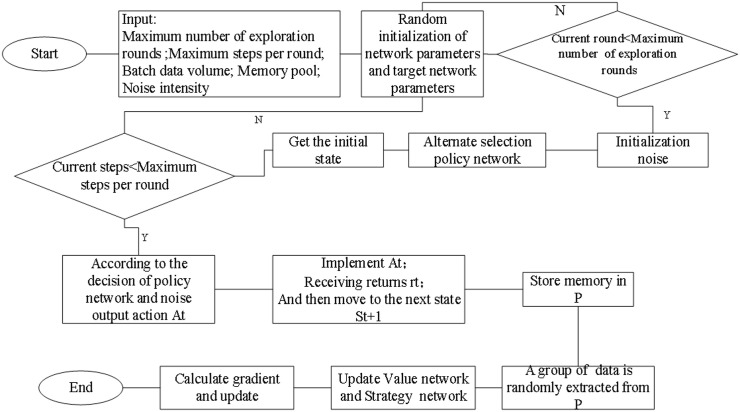
The overall implementation process of M-DDPG algorithm.